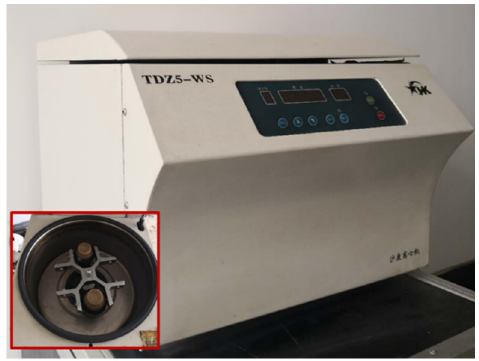
Figure 5. TDZ5-WS centrifuge and its internal structure.